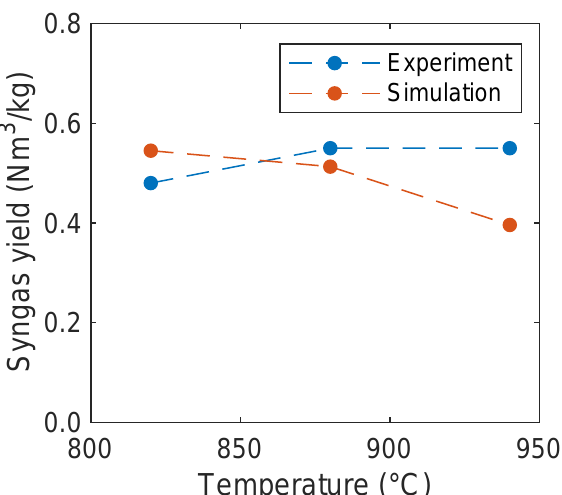
Figure 17. Syngas yield as a function of the reactor temperature in comparison with experimental data given by Condori et al. [5].